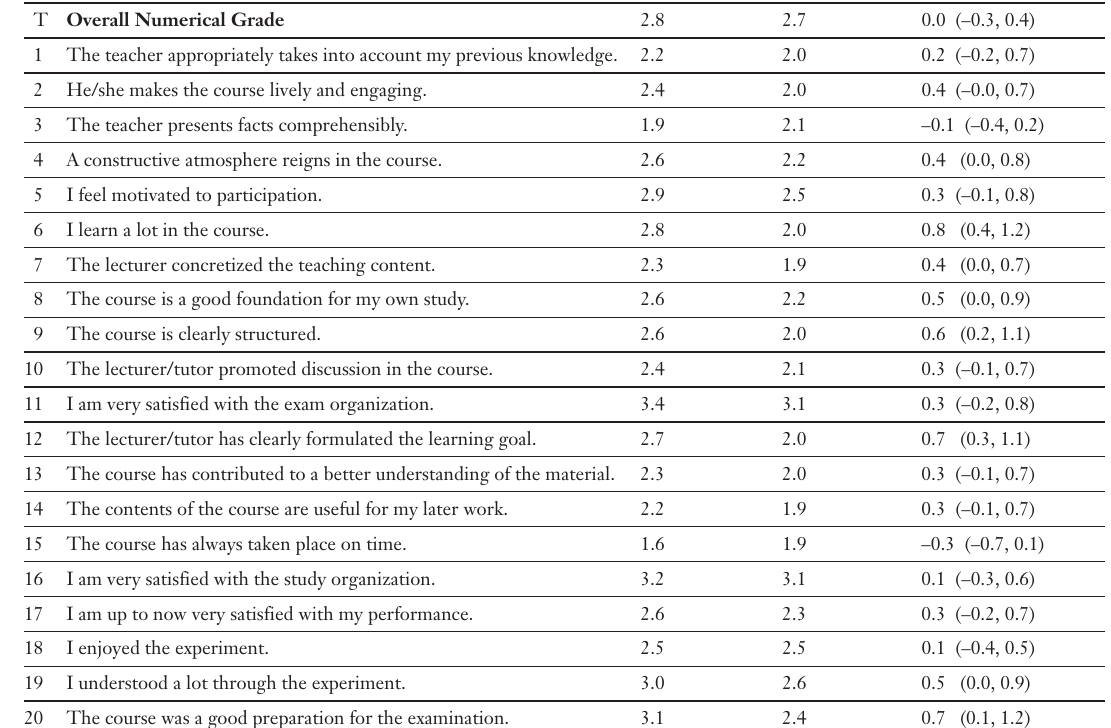
Table 3. Differences, between students from German-language secondary schools and students from foreign-language secondary schools, in the quantitative student evaluation of the Doctor/Patient Communication course. The means have been adjusted for age and sex. The last column pre- sents the difference between these means and the 95% confidence interval within which the true difference could